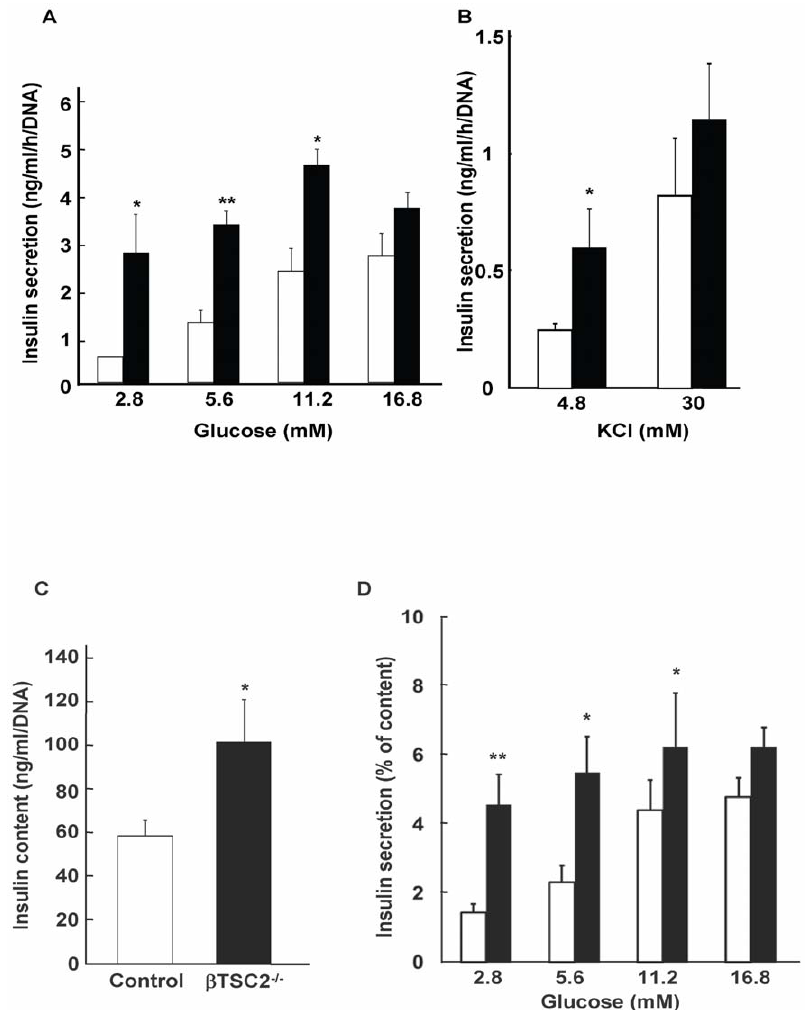
Figure 1. Effect of beta cell–specific ablation of TSC2 on insulin release and insulin content. ( A and B ) Insulin release in response to the indicated concentrations of glucose ( A ) or KCl ( B ) was measured with islets isolated from control (white bars) or b TSC2 2 / 2 (black bars) mice at the age of 8 weeks. Data were obtained from four independent experiments ( n =4–6). ( C ) Insulin content of isolated islets at the age of 8 weeks. ( D ) The amount of insulin secreted from the isolated islets normalised to insulin content. Data were obtained from two to three independent experiments ( n =4–6). All data are shown as means 6 SE of values from 4 animals of each genotype. * P , 0.05, ** P , 0.01 vs the corresponding value for control